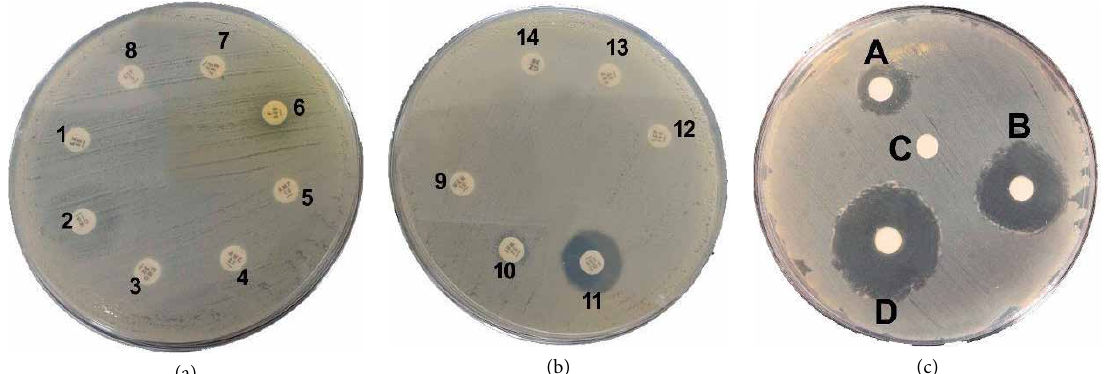
NPs, (b) Chitosan NPs, (c) CS-NPs coated TiO 2